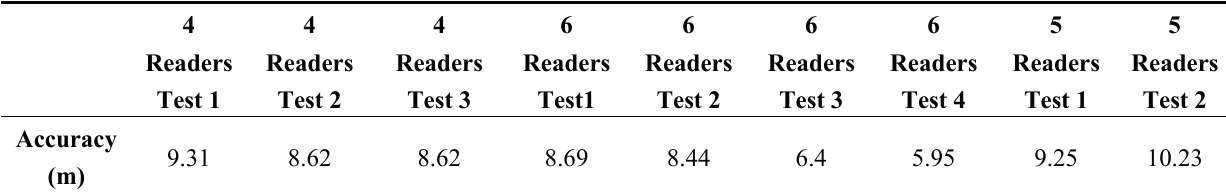
Table 4. The overall test results with different numbers of readers and at different